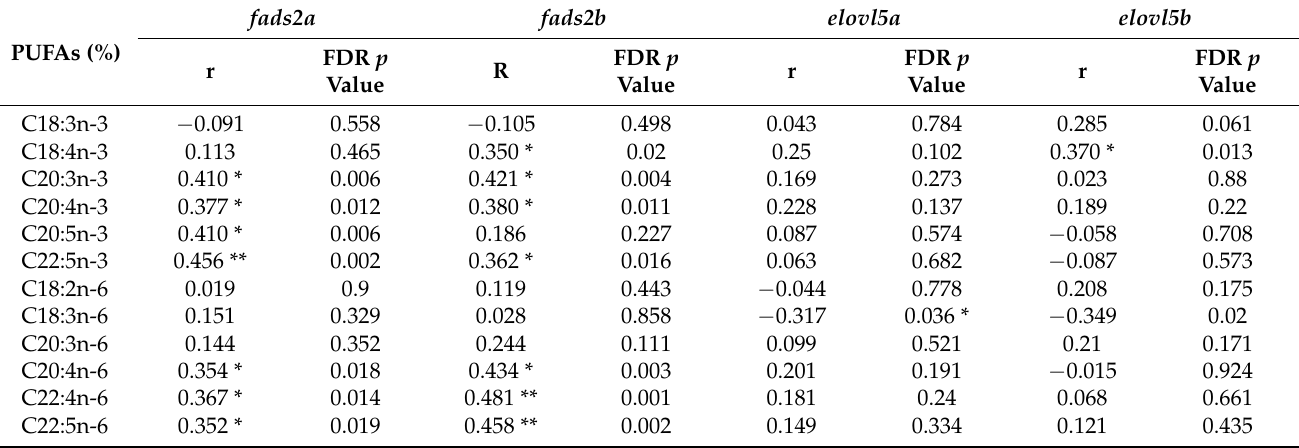
Table 5. The correlation between the expressions of four genes in liver and the contents of 12